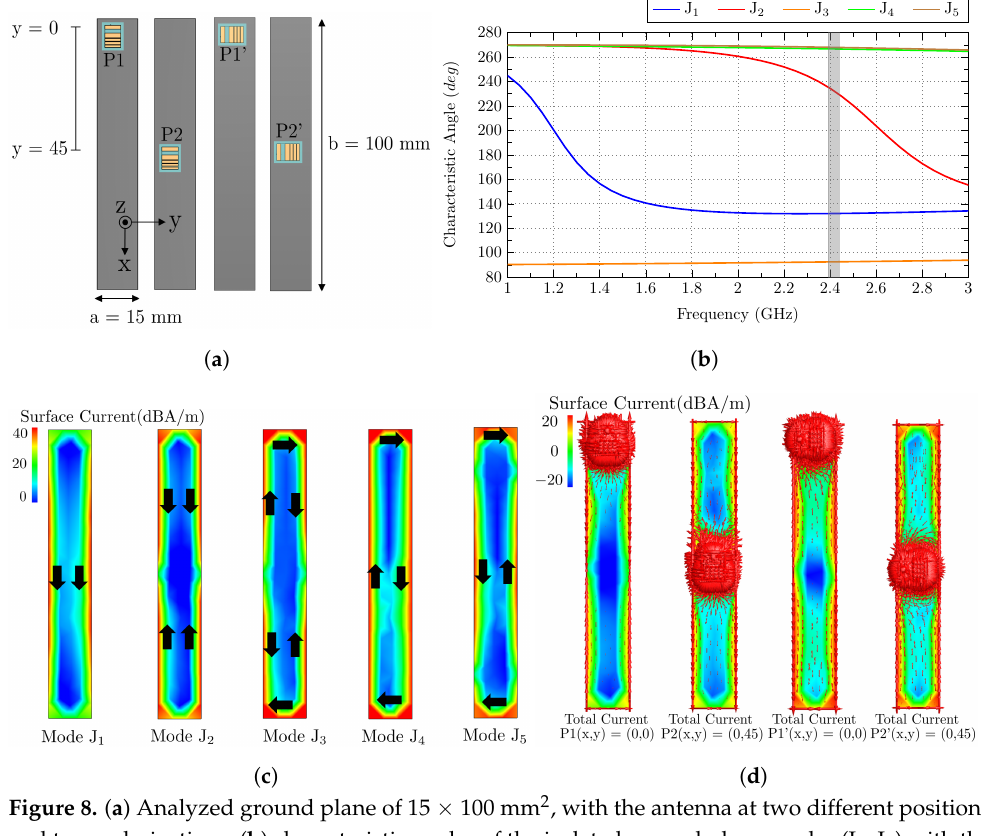
Figure 8. ( a ) Analyzed ground plane of 15 100 mm 2 , with the antenna at two different positions × and two polarizations, ( b ) characteristic angles of the isolated ground plane modes (J 1 –J 5 ) with the operating frequency band colored in gray, ( c ) current distribution of modes J 1 –J 5 of the isolated ground plane (black arrows describe the direction of the currents), and ( d ) total current distribution of the antenna at the four